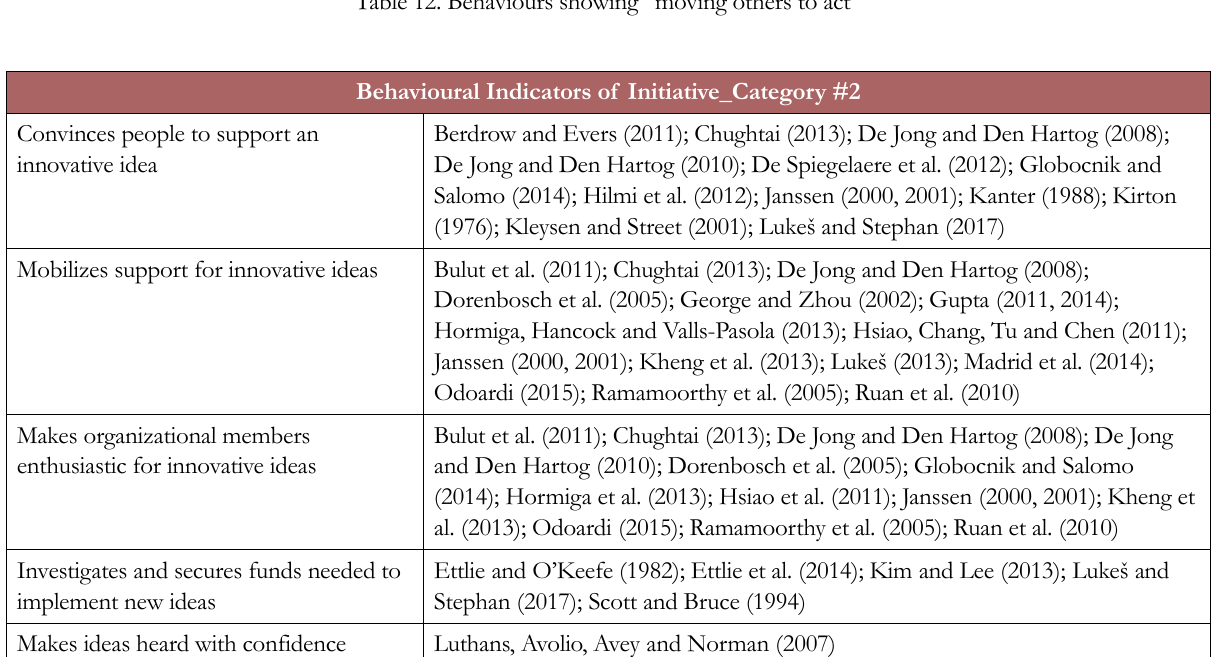
Table 13. Behaviours showing “mobilising important